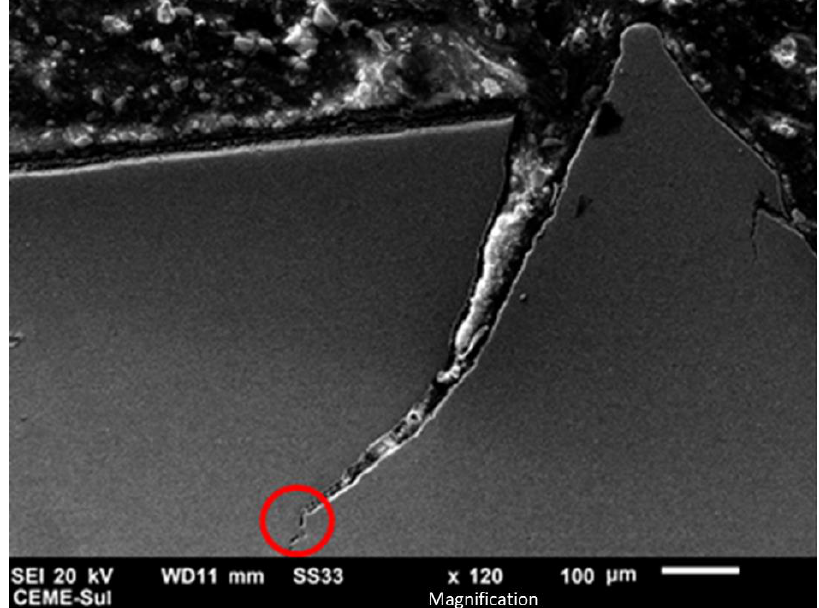
Figure 9. SEM of the material in the layer: crack region (source: author).